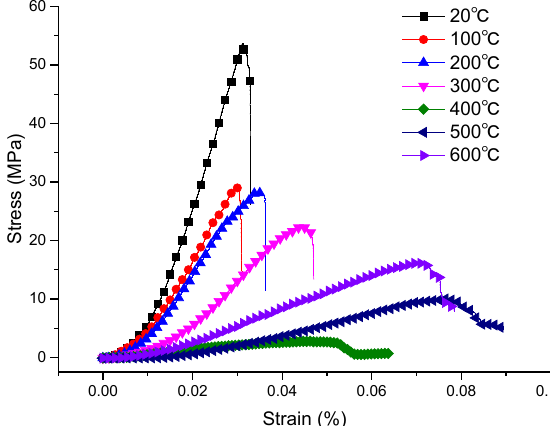
Figure 8. Stress–strain curve of oil shale at high temperatures.